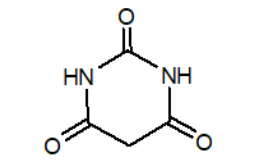
Fig. 1 . Barbituric Acid Barbituric acid is an organic building acid that can side and inside molecules when oxygen and nitrogen are present. When a (CH 2 ) group loses a hydrogen atom, the barbiturate anion forms, which is stabilized as a flat carbane by forming the resonant (Scheme 1), (Garcia et al.,